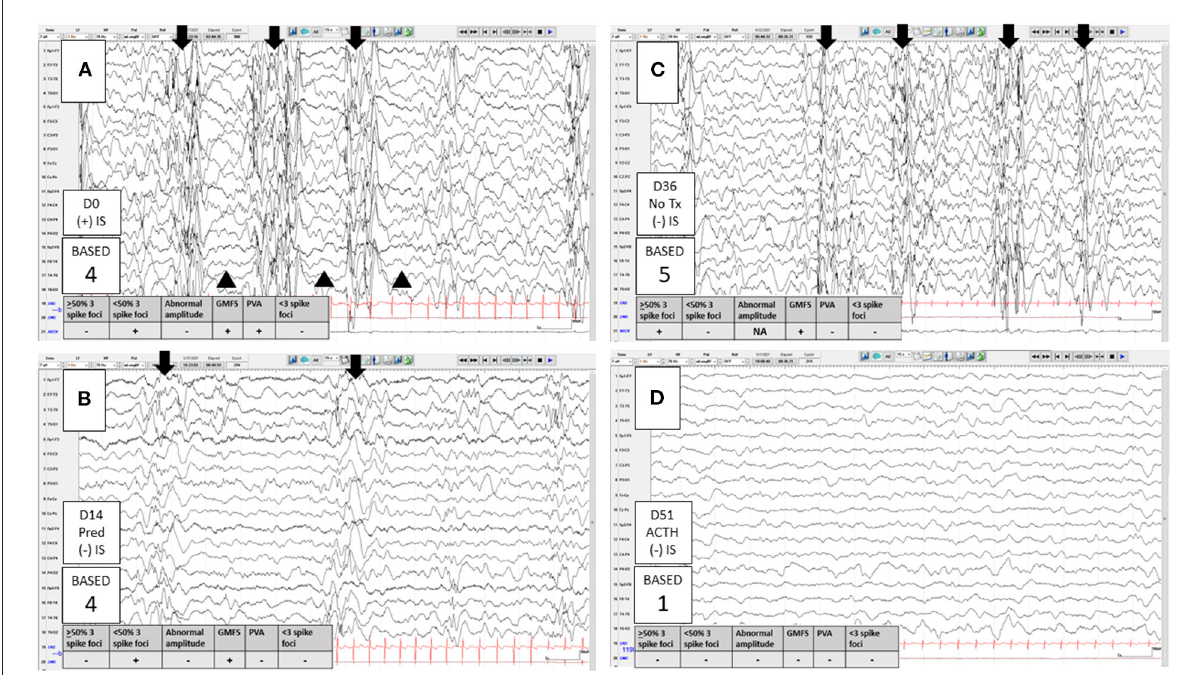
FIGURE1 Clinical application of the 2021 Burden of AmplitudeS and Epileptiform Discharges (BASED) score. A 4-month-old infant born at 39 weeks gestational age, with known developmental delay due to hypoxic ischemic encephalopathy, presented with new onset infantile spasms (IS). Onset of IS to treatment initiation was 1 day. (A) Day 0 (diagnosis and treatment), just < 50% of 1s (s) bins within a 5-min (m) epoch of sleep included at least one spike and there were grouped multifocal spikes (GMFS, arrows) as well as paroxysmal voltage attenuations (PVA, arrowheads). The presence of either GMFS or PVA indicated a BASED score of 4 (EEG findings to suggest a probable epileptic encephalopathy [EE]). (B) Day 14, IS and PVA resolved with high-dose prednisolone, with a subjective reduction in the burden of spikes. However, because of persistent GMFS (now less well-formed), the BASED score remained 4. At this point, there was no electrographic remission (pretreatment scores of 4 or 5 must improve to a 3 or less for remission). With the resolution of IS and subjective improvement on the EEG, the treating clinician did not pursue additional treatment at that time (despite the lack of electrographic remission by BASED score criteria). (C) Day 36, still no IS but the EEG showed a higher burden of spikes, now with > 50% of 1-s bins having at least one spike in a 5-m epoch of sleep, indicating a BASED score of 5 (EEG findings to suggest a definite EE). Better formed GMFS (arrows) were present. Notice that the background wave amplitude assessment is not reliable when the burden of spikes is ≥ 50%. High-dose adrenocorticotropic hormone (ACTH) was started at that time. (D) Day 51, all spikes resolved with ACTH. The background was slow and disorganized indicating a BASED score of 1 (Any definite non-epileptiform abnormality). This score, with the persistent remission of IS, indicated electro clinical remission. Longitudinal bipolar montage, Sensitivity 10 mv/mm, LFF 1Hz, HFF 70Hz, 15s per page. D, days; NA, not applicable; Pred, high-dose